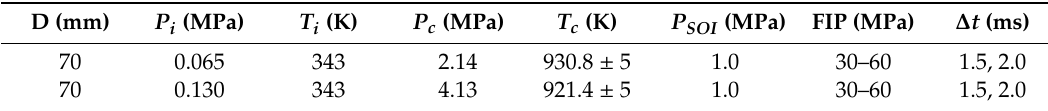
Table 2. Test conditions for RCM experiments.